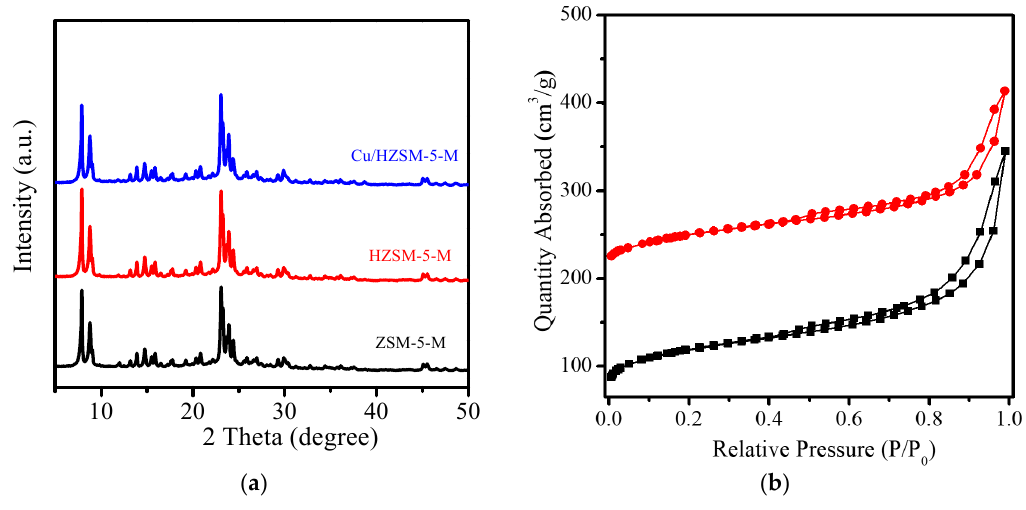
Figure 1. (a) XRD patterns of ZSM-5-M, HZSM-5-M and Cu/HZSM-5-M samples; ( b ) N 2 adsorption isotherms of the ( ■ ) ZSM-5-M and ( ● ) Cu/HZSM-5-M samples.